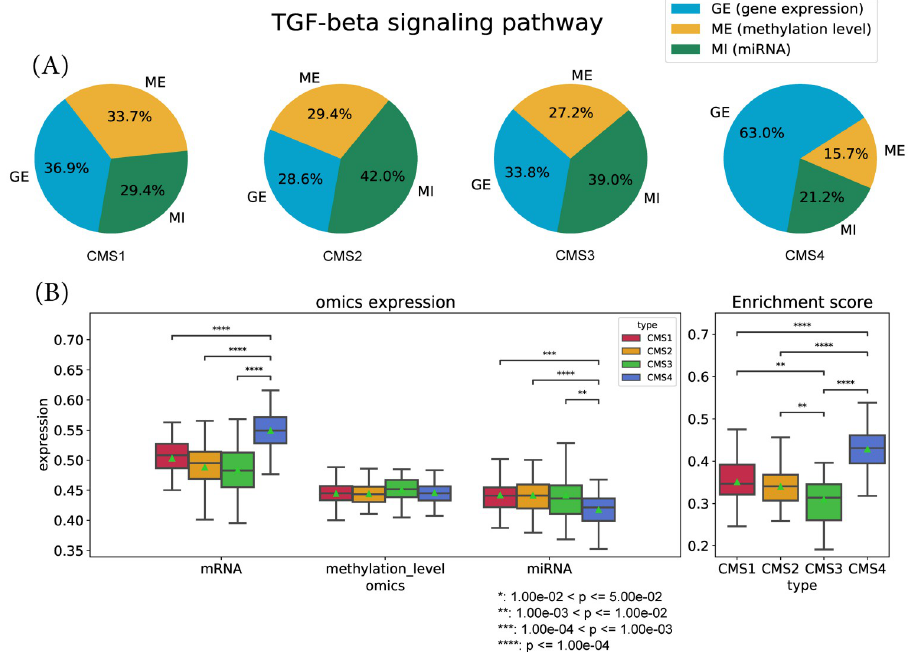
Fig 12. The ‘TGF beta signaling’ pathway analysis results. The OCR and mES of the ‘TGF-beta signaling’ pathway is shown. (A) The OCR of TGF-beta signaling pathway for each subtype. (B) The average gene omics values in the pathway (left) and the mES value for each subtype (right). The statistical significance is indicated.